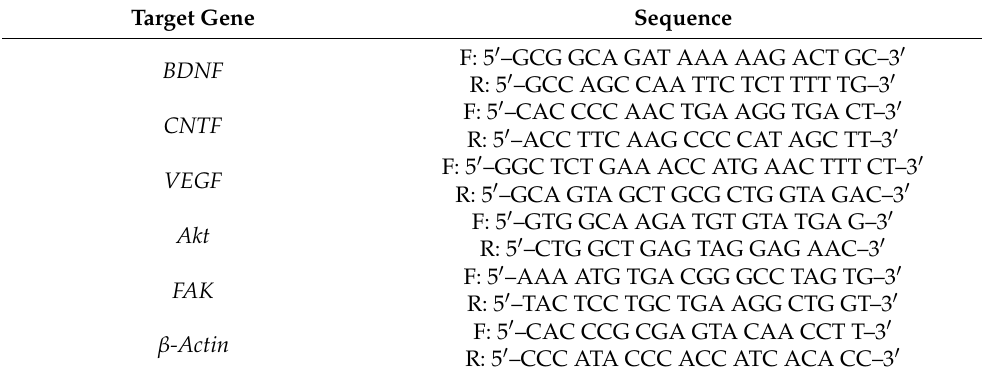
Table 1. Primers used for quantitative reverse transcription polymerase chain